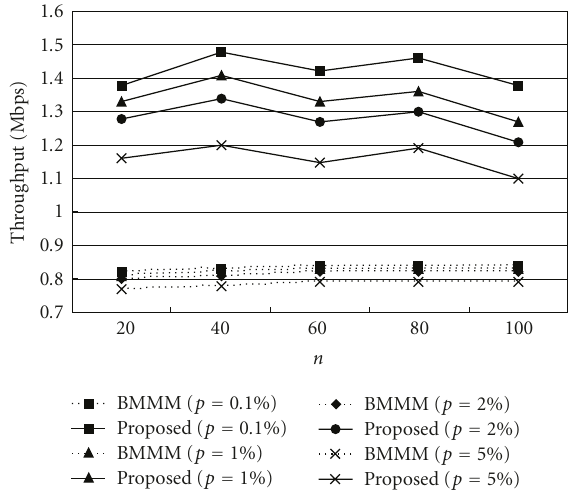
Figure 1: Throughput results with multicast and uplink user payloads of 88 bits.